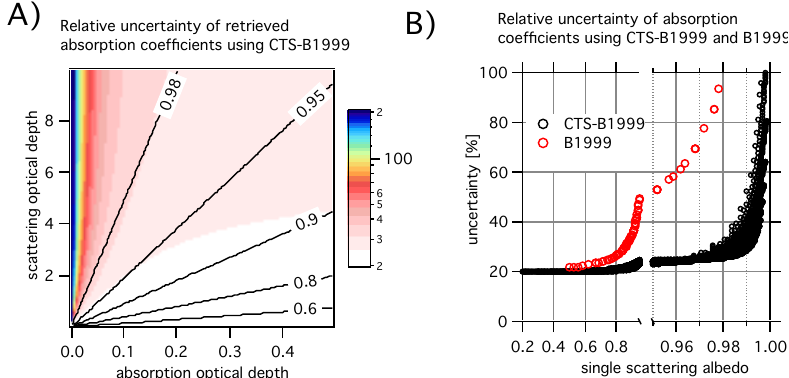
Figure 14. (a) Total relative uncertainty in absorption coefficients retrieved by CTS using the B1999 black aerosol calibration (CTS-B1999). The uncertainty is calculated by error propagation of model and calibration uncertainties. (b) Total uncertainty in absorption coefficients versus particle single-scattering albedo for CTS-B1999 (black) and for B1999 (red).